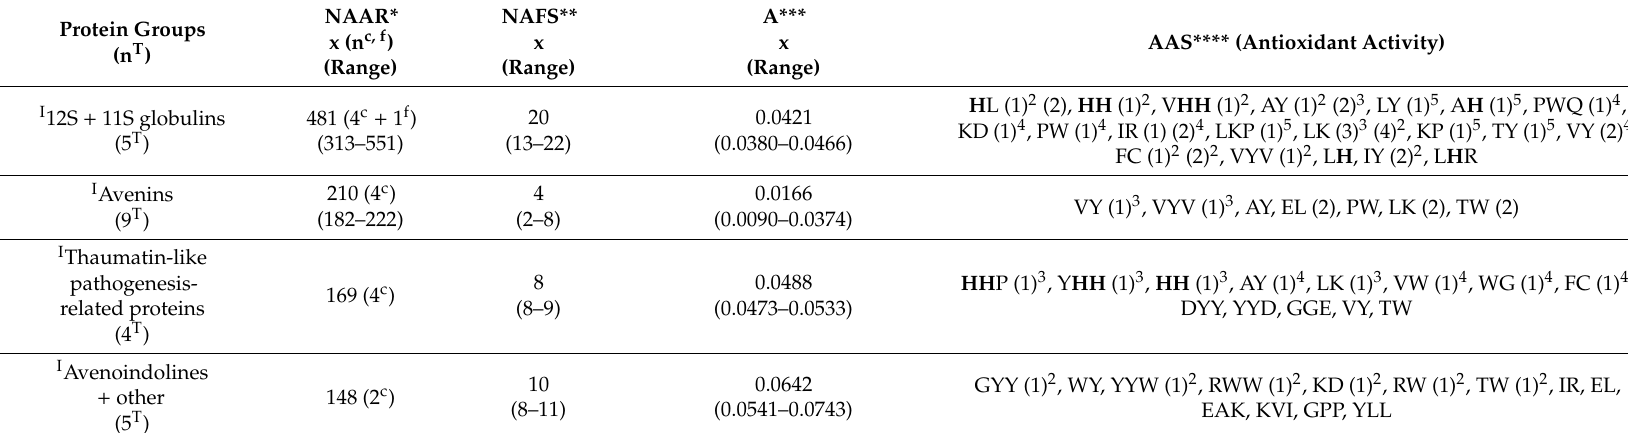
Table 4. Characteristics of oat proteins antioxidant activity ( I Avena sativa)